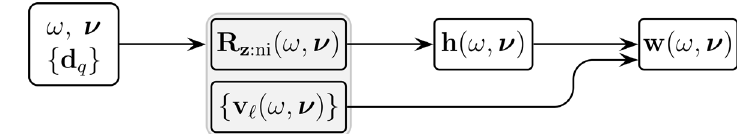
Fig. 4 Workflow for computation of MVDR subband beamforming